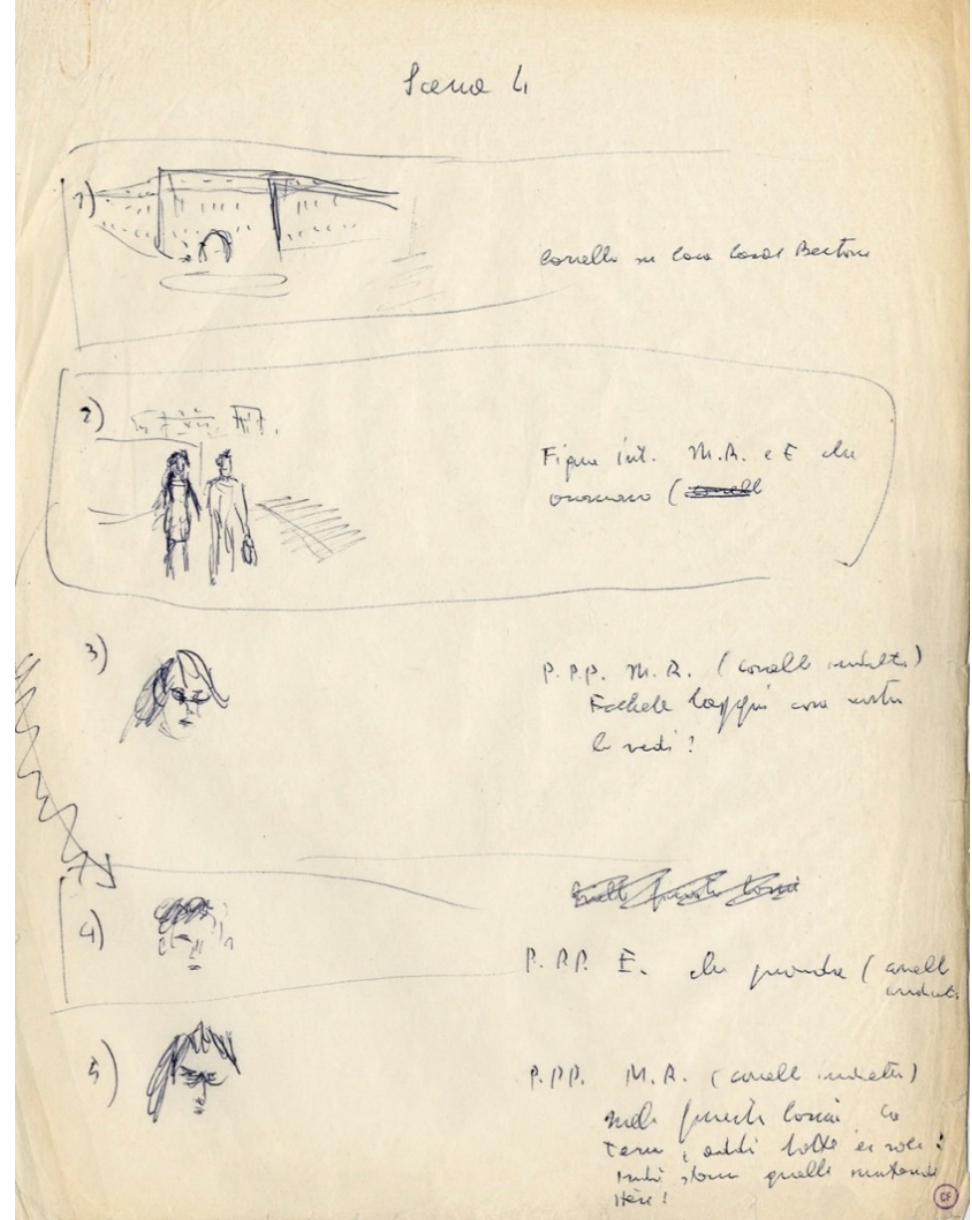
Figure 4. Pier Paolo Pasolini’s manuscript sketch for Scene 4 of Mamma Roma. Credits: Cine ́ mathe ̀ que franc ̧ aise. Gift of Pier Paolo Pasolini.